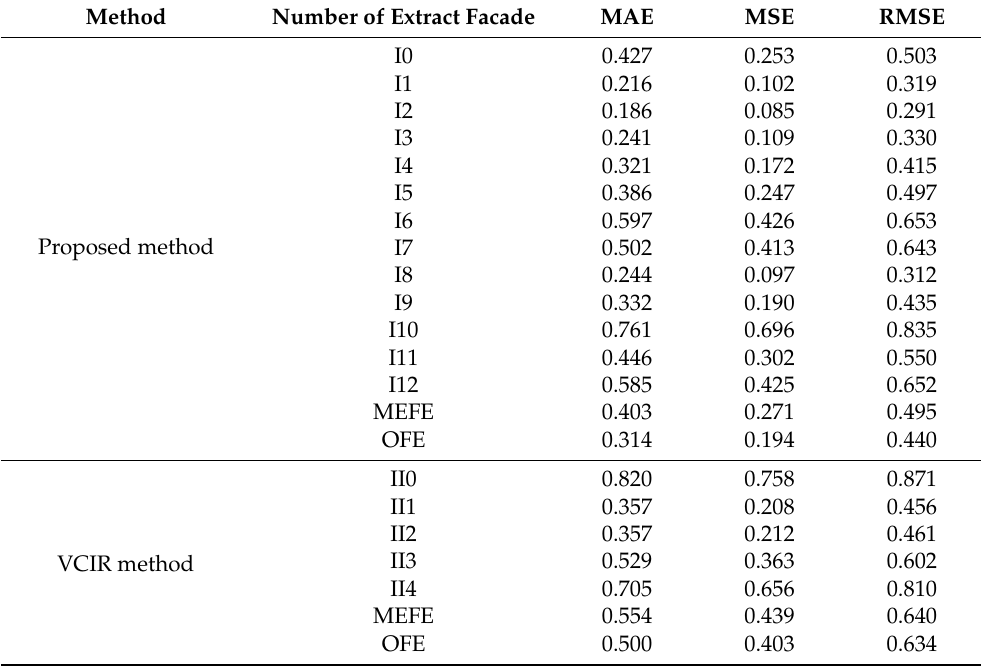
Table 1. Errors of facade extraction for the IQmulus & TerraMobilita Contest